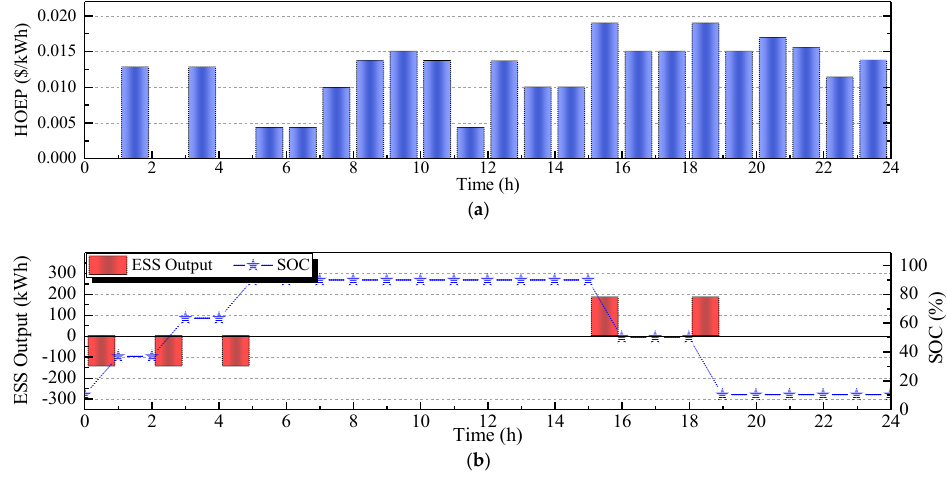
Figure A3. Results of Case 2: ( a ) Forecasted HOEP; ( b ) Scheduled output and SOC of the ESS. Case 3